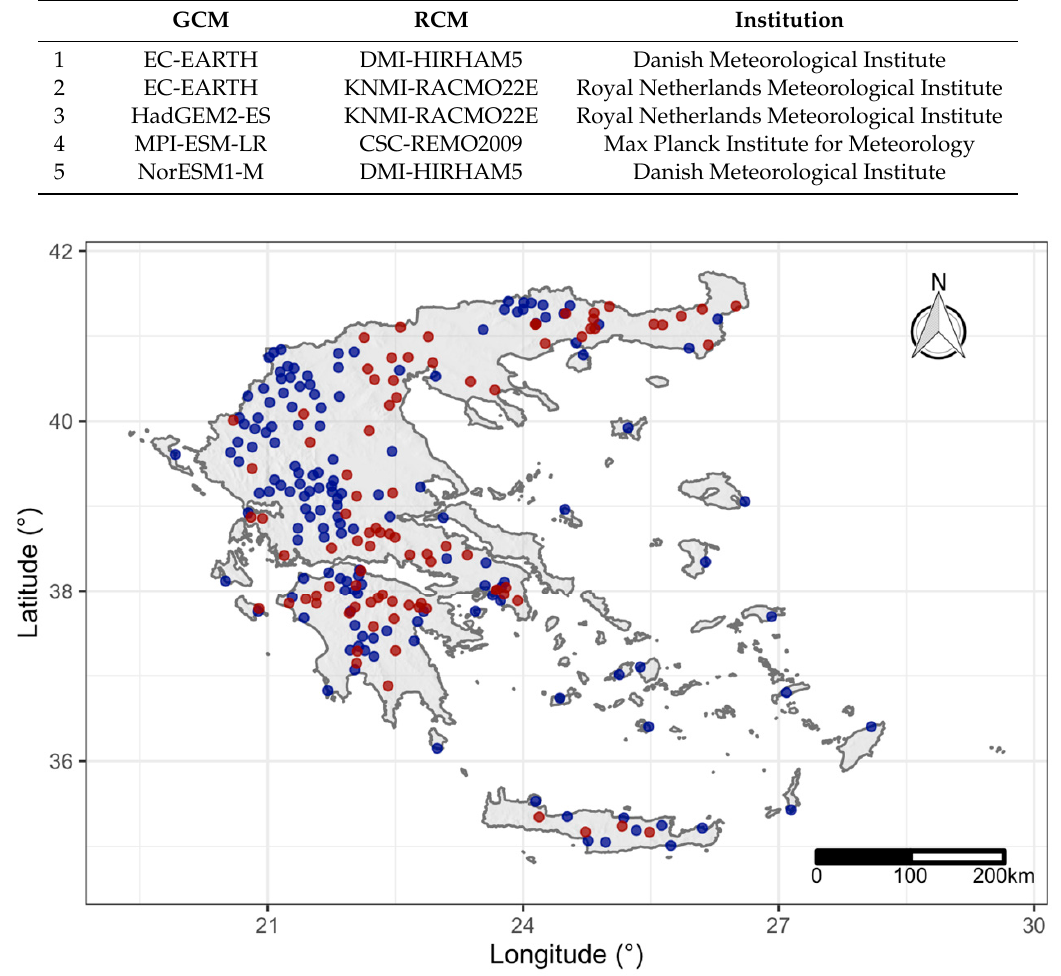
Figure 2. Station locations in Greece used in the analysis. Red points symbolize the 87 stations with pluviograph data from the Greek National Bank of Hydrological and Meteorological Information (NBHM) and blue points are the 150 stations with average monthly precipitation from the Hellenic National Meteorological Service